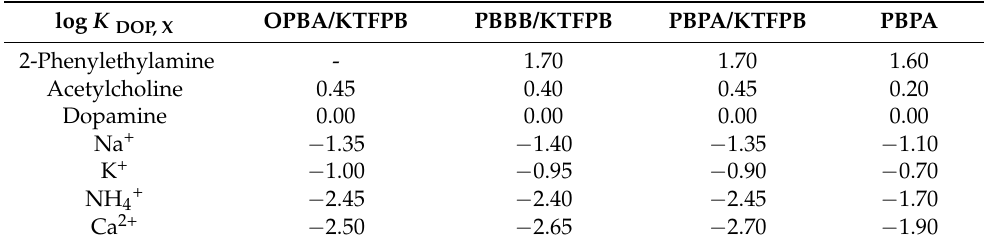
Table 2. Values of selectivity coefficients (log K DOP, X ) of ion-selective electrodes formulated with studied organoboron receptors with 10 mol % KTFPB and without KTFPB in membranes (mean values calculated for three electrode specimens).